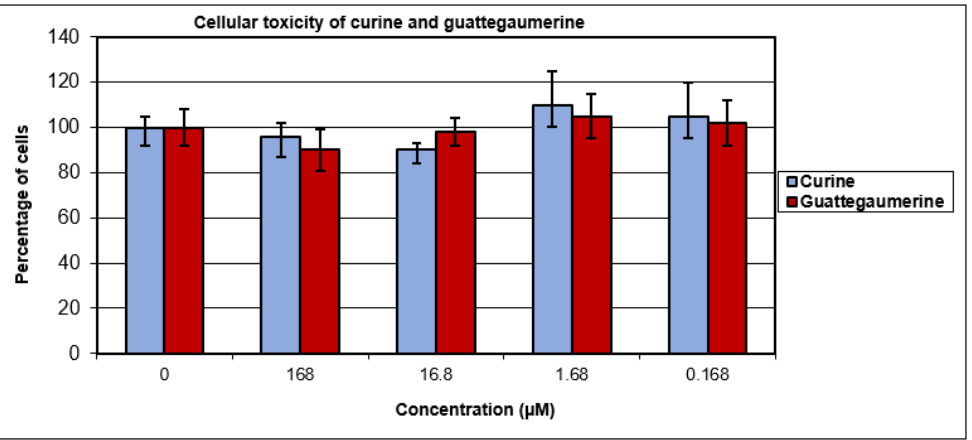
Figure 2. Cellular toxicity of curine and guattegaumerine. HTC-R cells were grown to confluence in 24-well plates and exposed for 24 h at the concentrations of curine or guattegaumerine indicated in abscissas. The percentage of surviving cells is plotted in ordinates. Experiments were performed three times in triplicate. Values represent the mean percentage of surviving cells ± standard deviation.